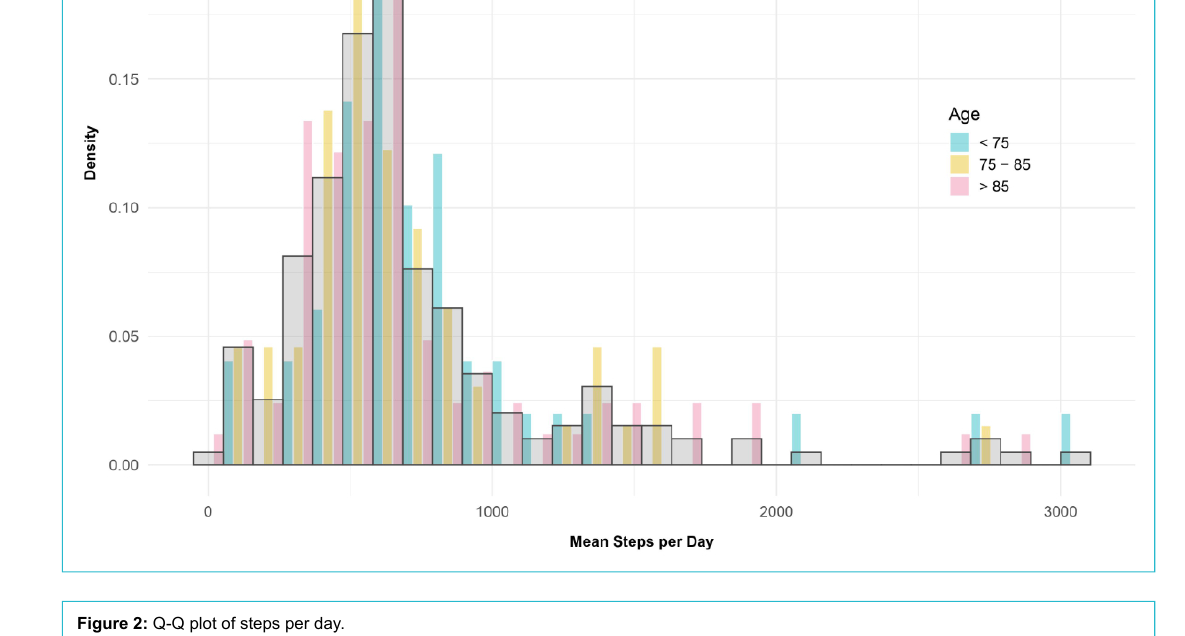
Figure 2: Q-Q plot of steps per